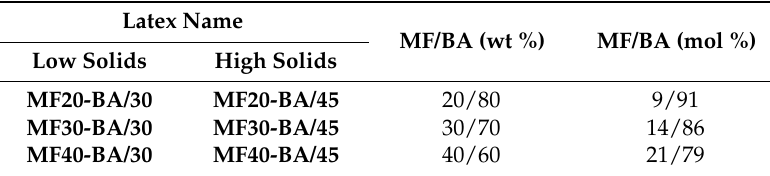
Table 1. Studied methacrylate sugar-based copolymer compositions (in terms of both weight and molar fractions) and their nomenclature.